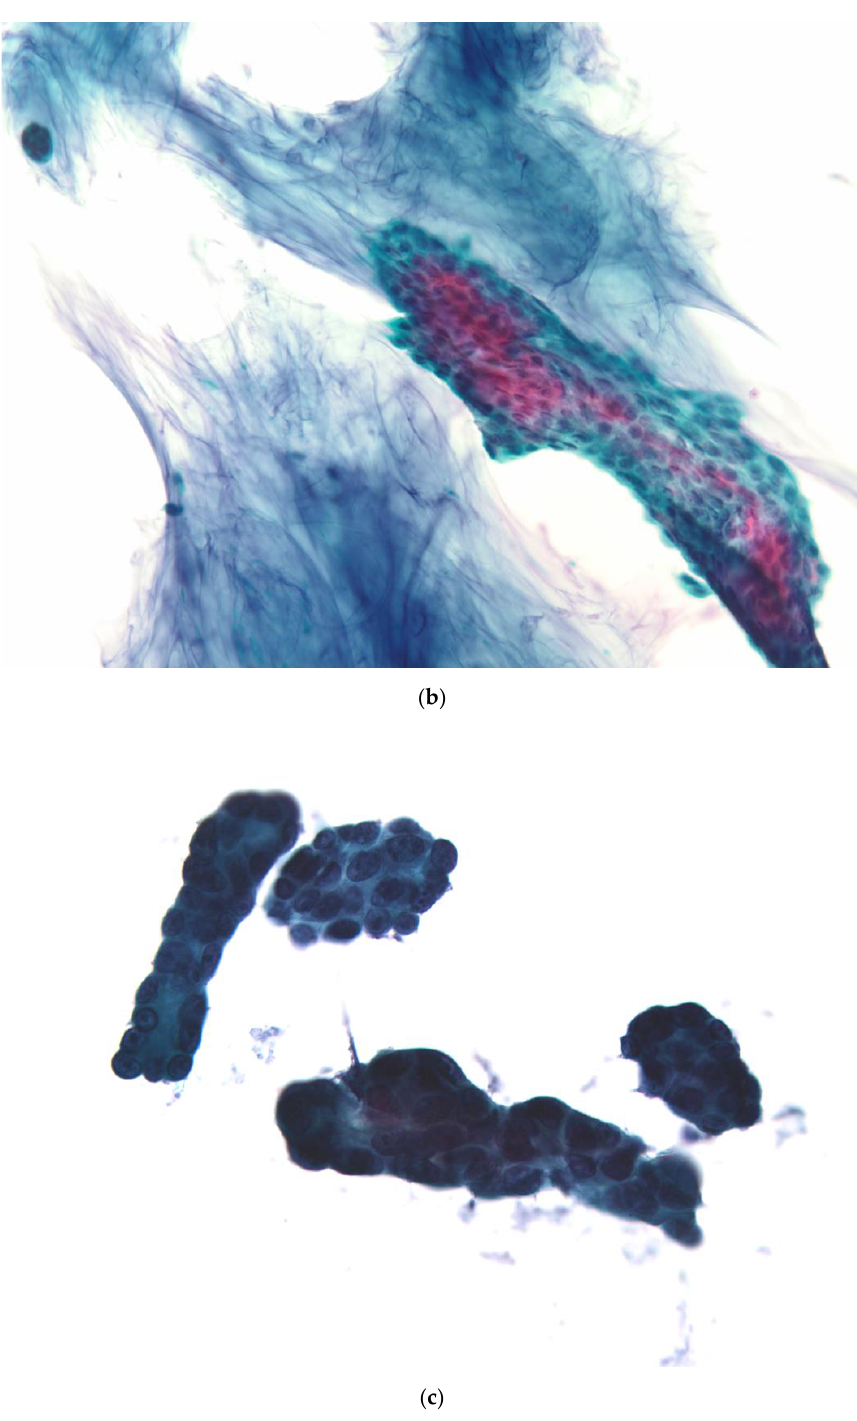
Figure 3. ( a ) Giemsa-stained, air-dried smear of metaplastic carcinoma (matrix-producing carcinoma). ( b ) Papanicolaou-stained, ethanol-fixed direct smear of mucinous breast carcinoma with groups of tumor cells floating in abundant extracellular mucin. This type of breast carcinoma is usually hormone-receptor-positive, with a good prognosis and a relatively low rate of distant metastases. ( c ) Cytology liquid-based SurePath preparation of metastatic micropapillary carcinoma, Papanicolaou- stained. The tumor cells consist of finger-shaped, three-dimensional groups. While cytologically of intermediate grade, this morphological type of breast cancer shows frequent lymphatic vessel invasion and has high metastatic